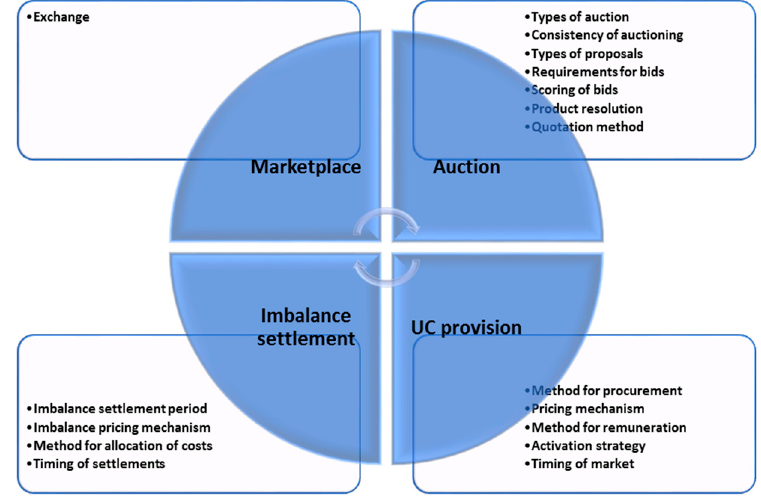
Figure 12. Information that should be published about market for frequency and voltage control.